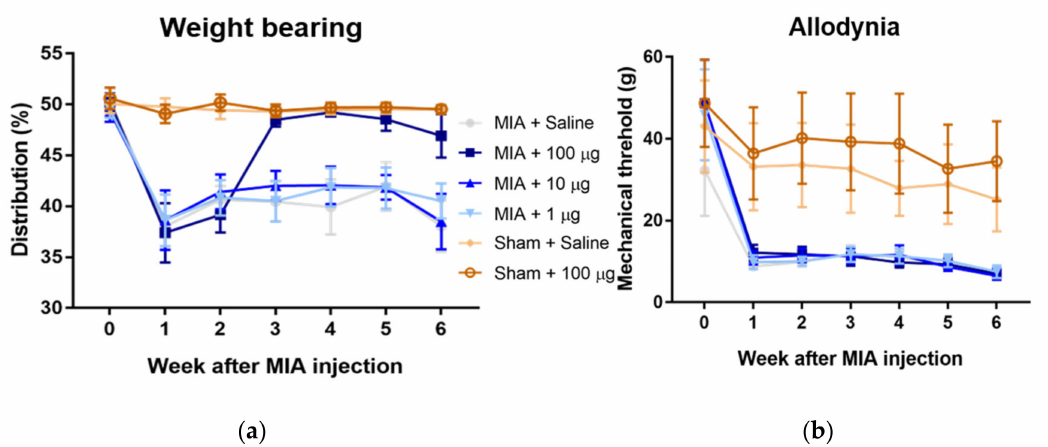
Figure 1. Anti-nerve growth factor (NGF) antibody treatment relieved the pain in a rat osteoarthritis (OA) model, as evidenced by improved weight-bearing performance but not allodynia. ( a ) Monoiodoacetate (MIA) injection can induce weight-bearing asymmetry, whereas a saline injection did not show any significant changes in the rat’s weight-bearing performance. Moreover, 100 µ g of anti-NGF antibody treatment reduced pain in the rat OA model, as evident from the improvement in weight-bearing performance ( p < 0.0001). Furthermore, 1 and 10 µ g antibody treatment did not improve the weight-bearing performance after MIA injection. The results represent the 95% confidence intervals for six rats. ( b ) MIA injection significantly lowered rat hind paw withdrawal mechanical thresholds compared to saline injection. No significant improvement in allodynia was observed after the injection of the NGF antibody at any doses. The results represent the 95% confidence intervals for six rats.